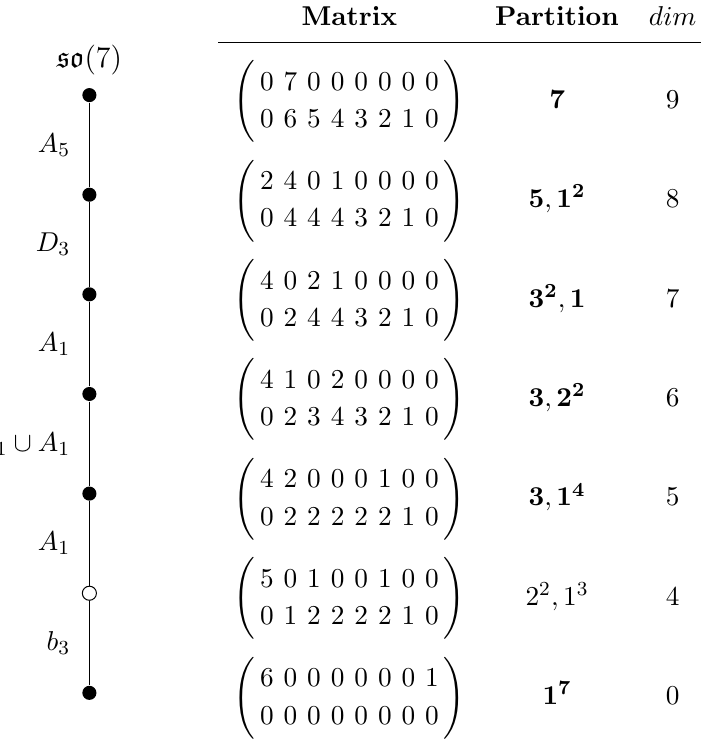
Table 14. Results obtained applying the matrix formalism to so